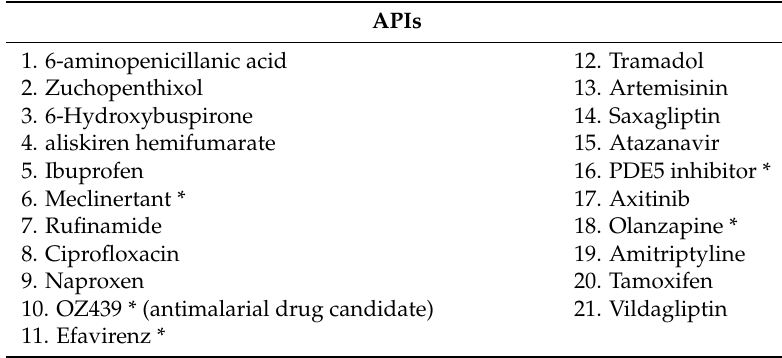
Table 7. List of APIs and final drugs (*) in the database, of which complete reaction pathway and the reactions are provided in the database.